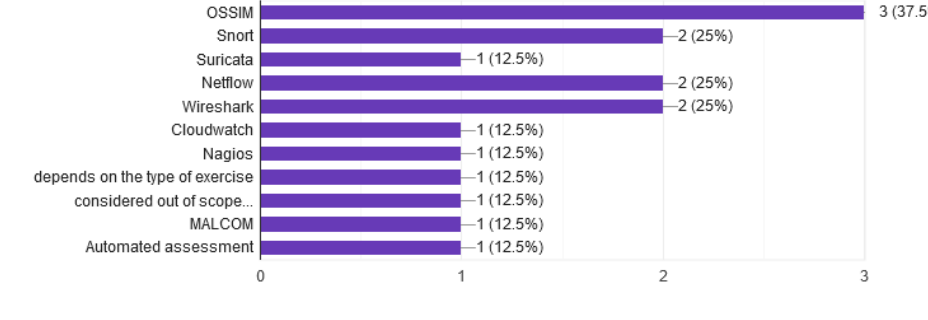
Figure 14. Tools to monitor.